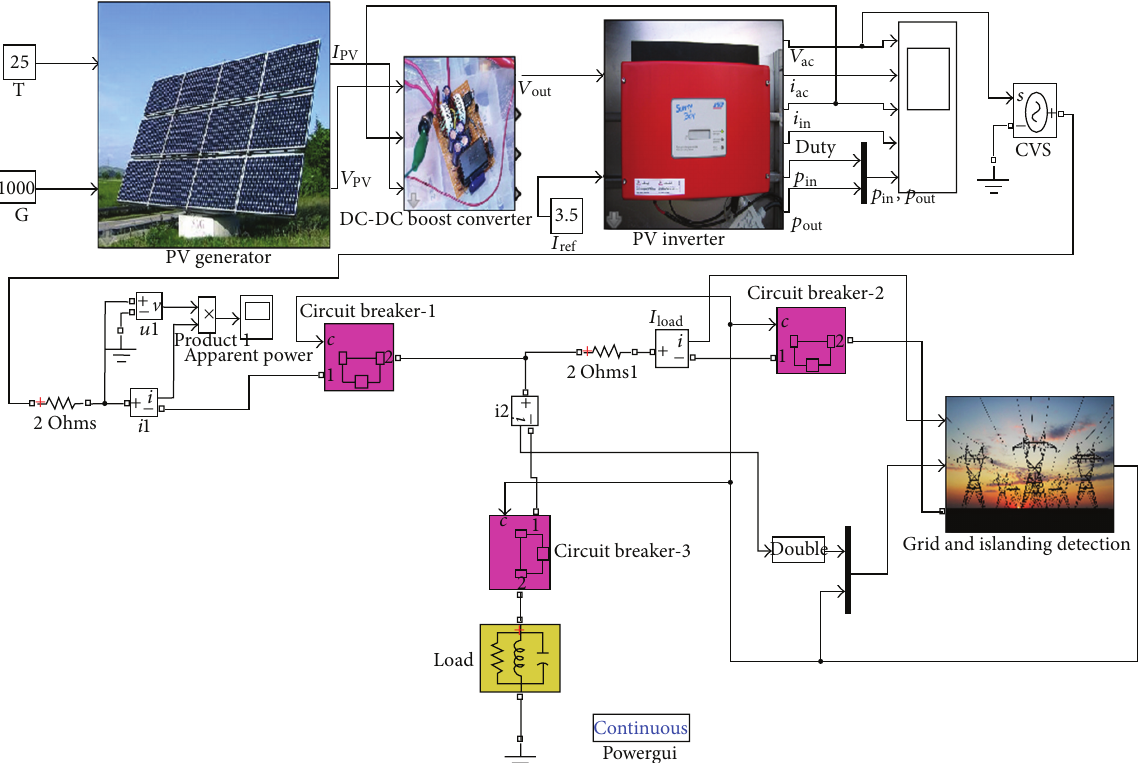
Figure 8: Simulation model of the proposed islanding detection